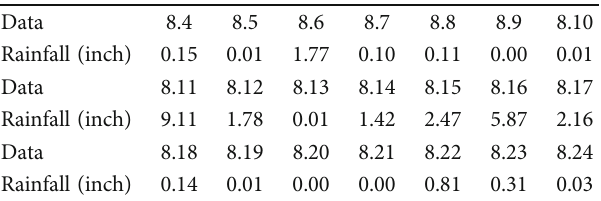
Table 1: Daily rainfall data (average) of the observatory